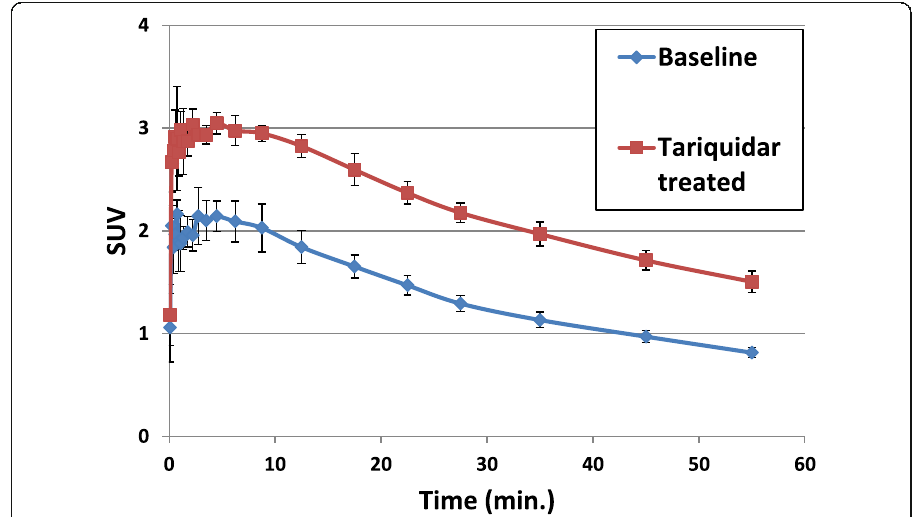
Fig. 6 Whole brain time activity curves of [ 18 F] 5 before (blue diamonds) and after (red squares) 15 mg/kg tariquidar (a specific P-gp inhibitor)